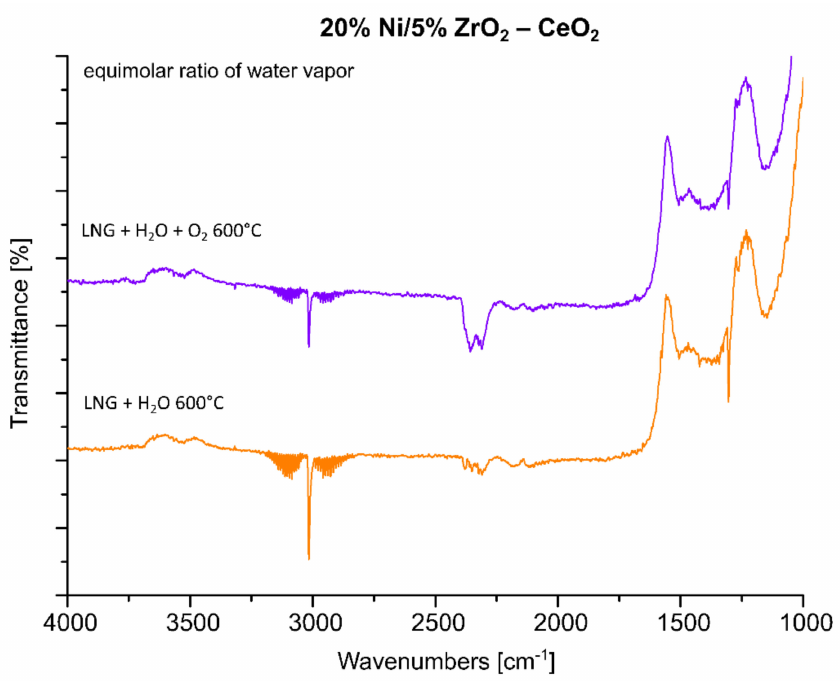
Figure 12. In situ IR spectra under steam and oxy-steam reforming of LNG conditions at 600 ◦ C recorded for the 20% Ni/5% ZrO 2 –CeO 2 catalyst.